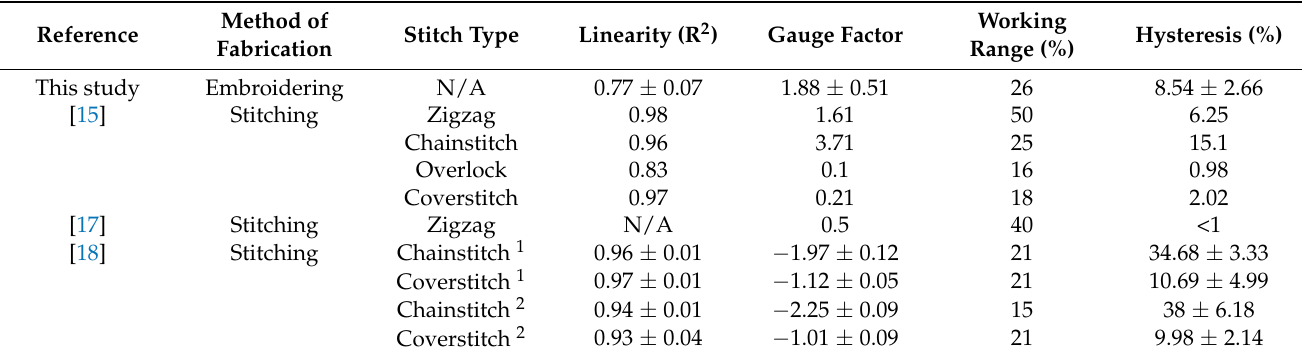
Table 2. Performance comparison of stitched sensors and the embroidered sensor presented in this